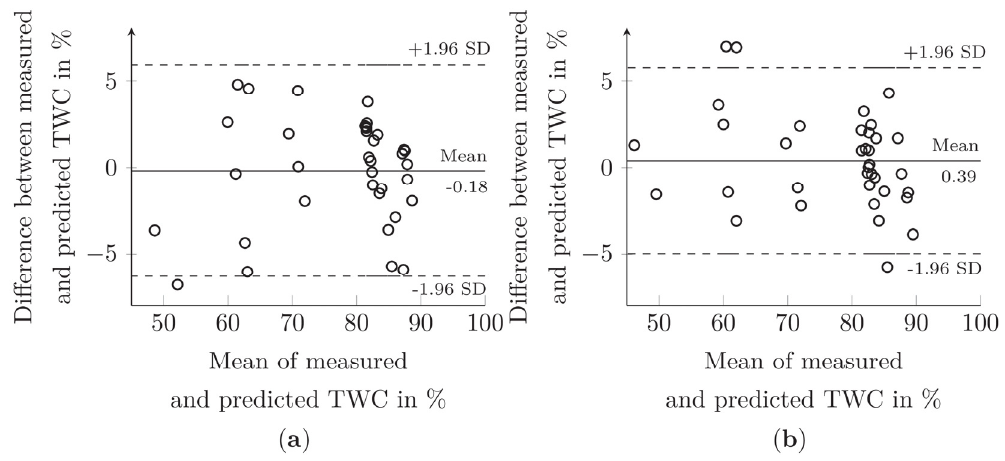
Figure 9. TWC distribution map of a kidney during NMP. 4. Discussion This study demonstrated the feasibility of HSI in combination with PLSR to assess the TWC in porcine kidneys during NMP. Here, the wavelength range of 500 to 995 nm could be used to identify water-related characteristics of kidney tissue. PLSR models derived from the analysis of a suitable dataset were applied to quantify TWC. A model based on the absorbance spectra of the full wavelength range yielded the best performance in predicting the TWC and was used to visualize the TWC distribution of the kidneys’ surface. 4.1. Hyperspectral Imaging for Spectral Characterization of Kidney Tissue in the VIS/NIR Region HSI enables fast and non-invasive measurement of tissue properties in, e.g., medical applications. Using this technique, information about physiological and pathological tissue characteristics can be obtained [20–25]. Water-specific tissue features of the kidney were assessed using HSI in the wavelength range between 500 and 995 nm. By predicting the TWC, tissue-related damage during ex vivo preservation could be detected in the future. Depending on the medical application, the analyzed HSI spectral range varies between 400 and 2500 nm. However, tissue characterization is preferably performed in the optical window between